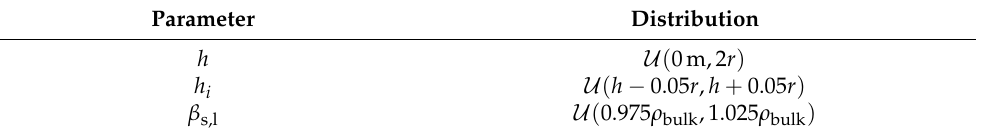
Table 1. Parameters and their respective distributions for the Monte Carlo simulation for model validation.